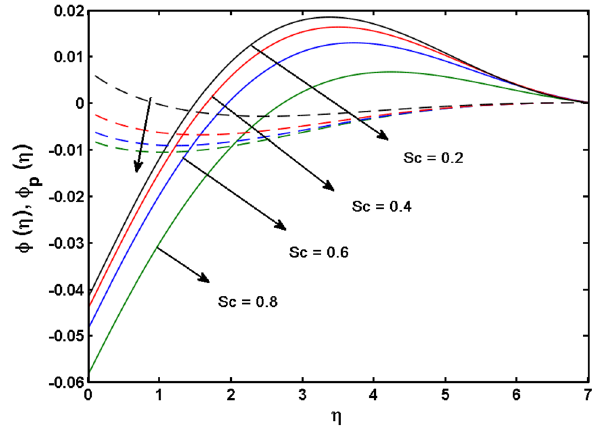
Figure 15. φ(η) for various estimates of Sc .